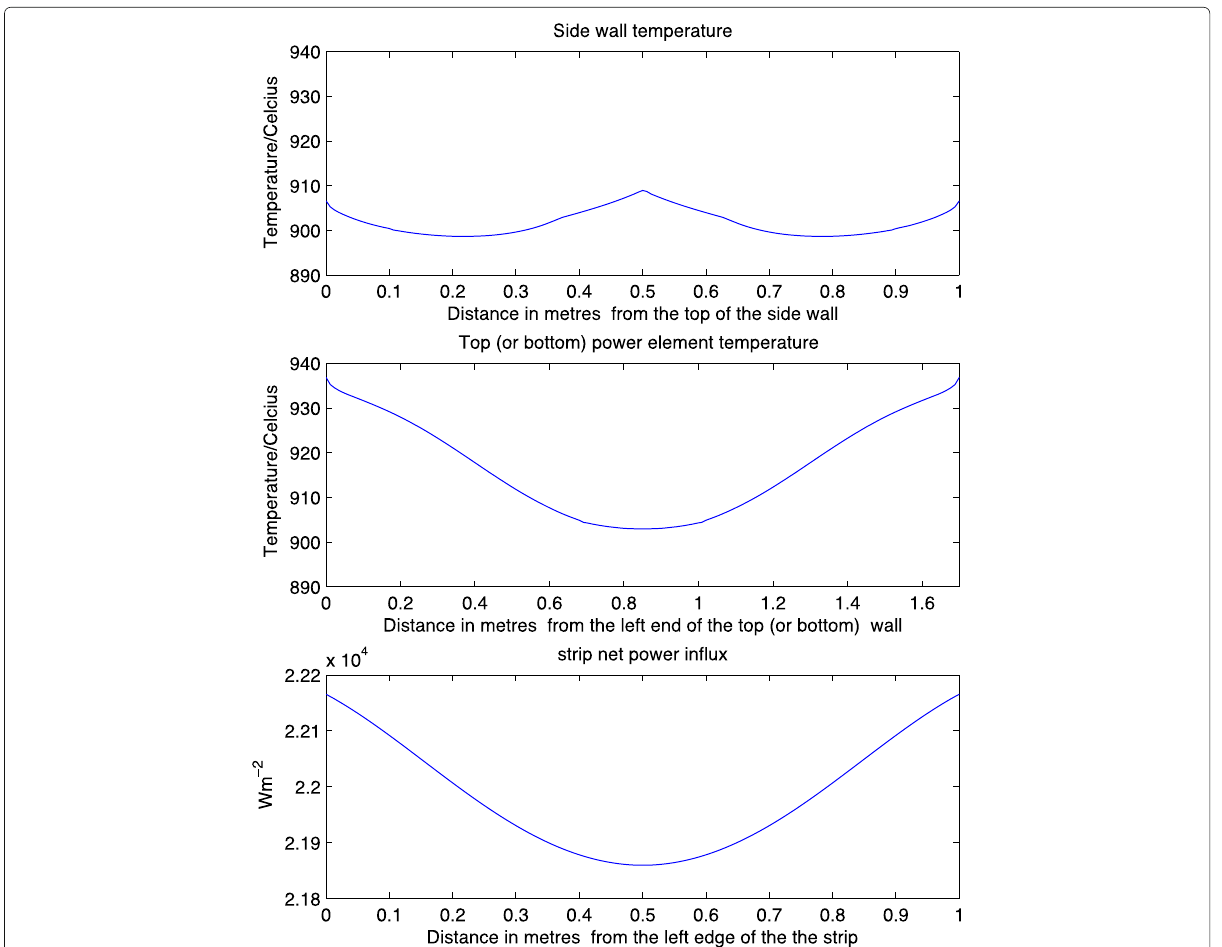
Fig. 11 Case 2: T S = 20 ◦